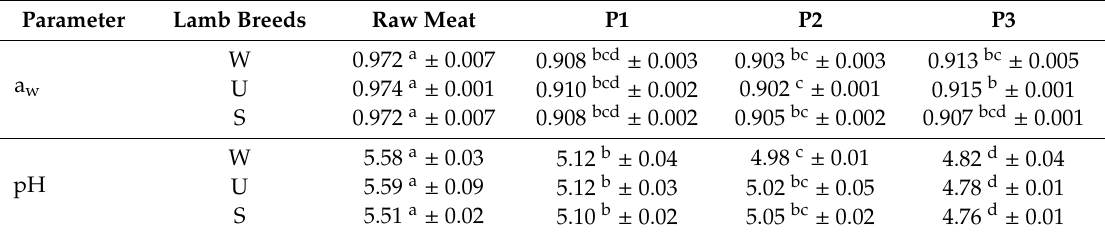
Table 1. pH and water activity of lamb raw meat and products (mean ± standard deviation). Parameter Lamb Breeds